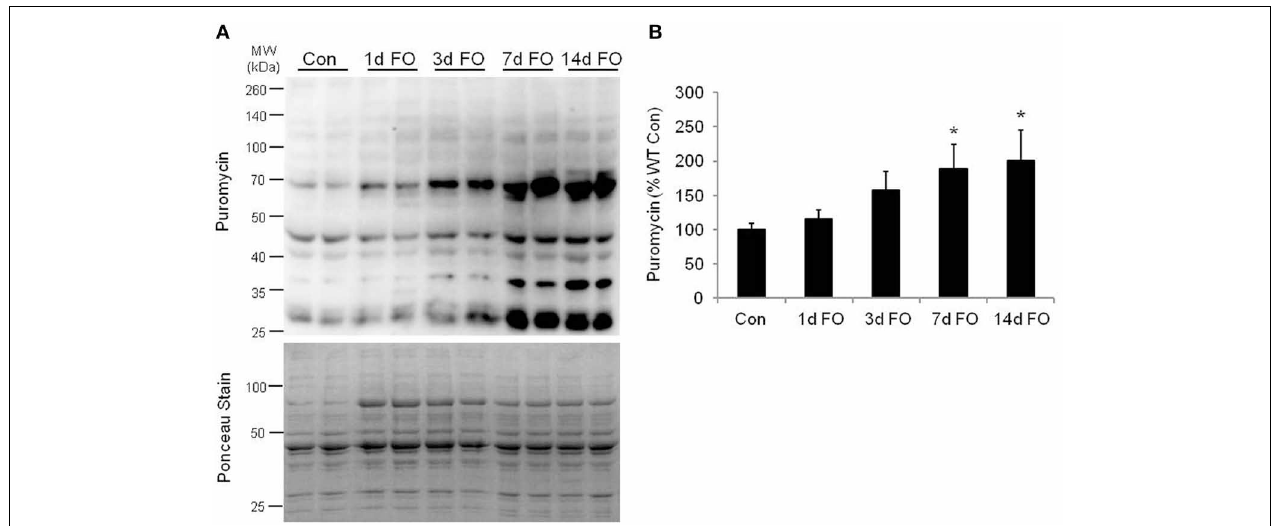
FIGURE 2 | Measurement of protein synthesis using the SUnSET method following functional overload (FO). (A) Representative image of western blot analysis for puromycin following no treatment (Con) and FO for 1, 3, 7, or 14 days in WT mice. The corresponding ponceau stain was used to